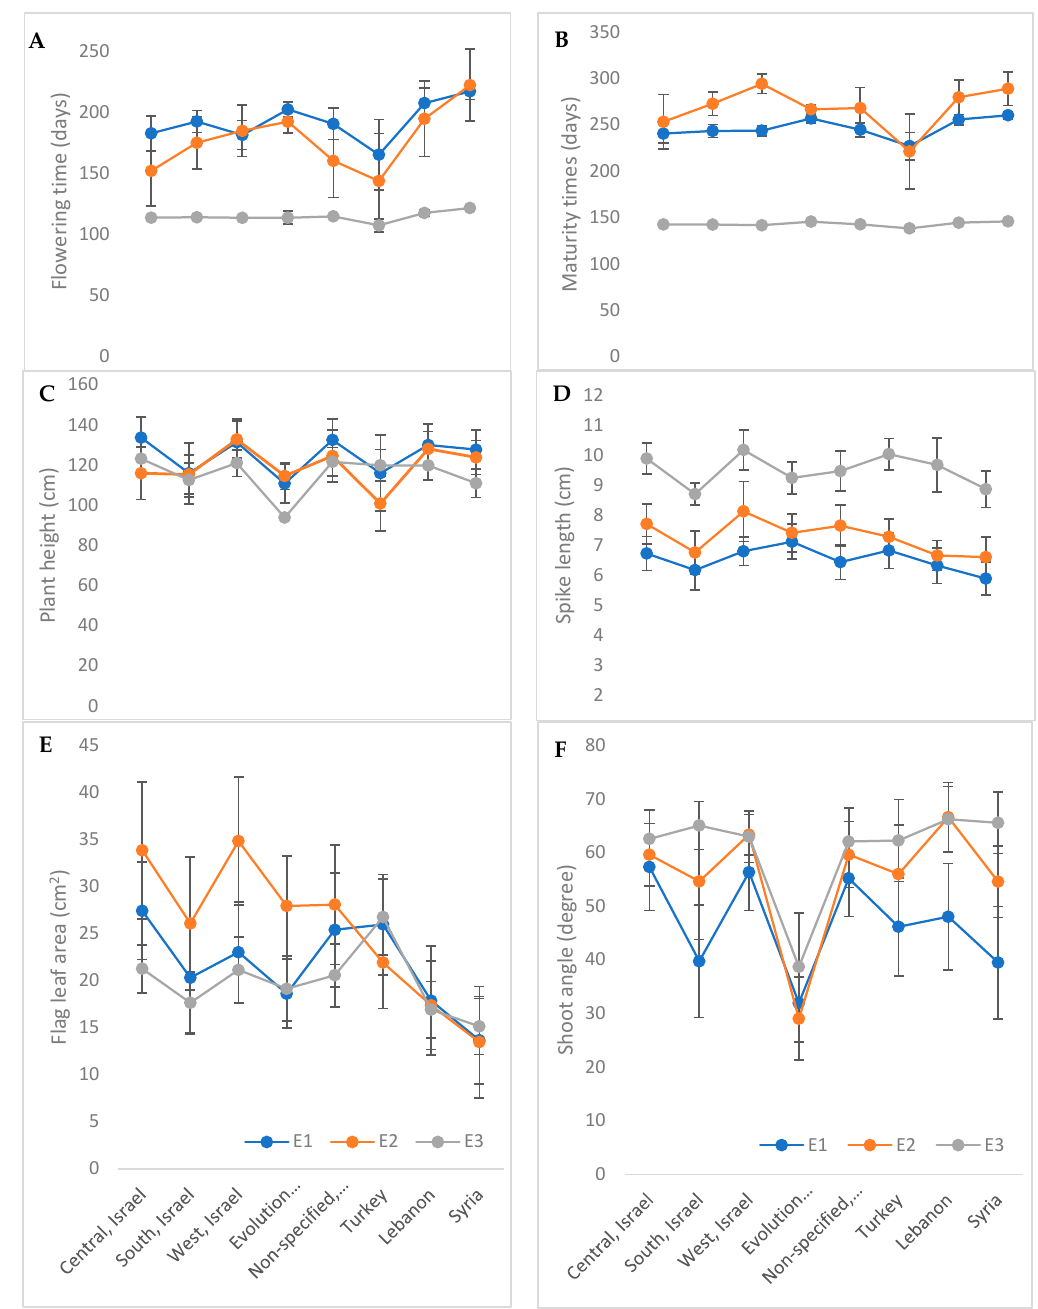
Figure 5. Performance of different populations in three environments (E1, E2, and E3) based on Flowering time ( A ), Maturity time ( B ), Plant height ( C ), Spike length ( D ), Flag leaf area ( E ), and Shoot angle ( F ). Error bar denotes mean ± SD.